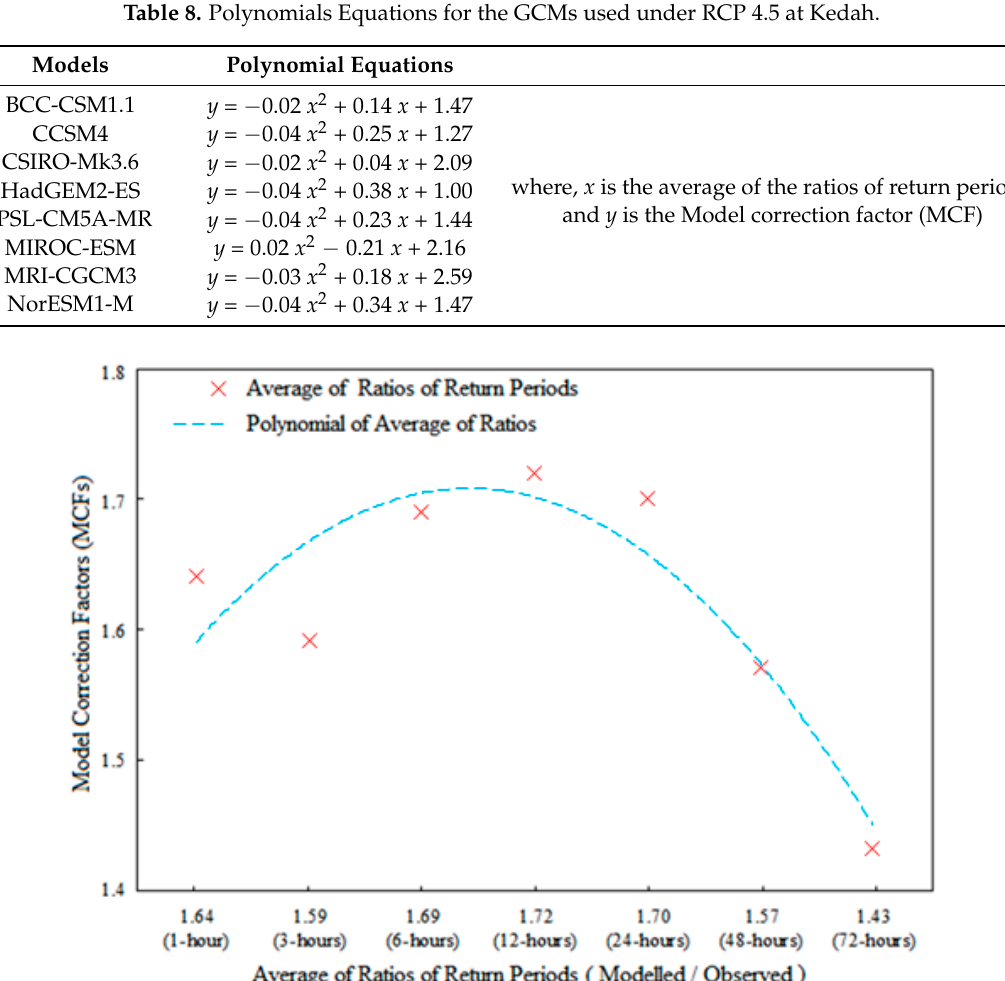
Figure 8. Model Correction Factors (MCFs) for modelled rainfall intensities fitted into a polynomial equation for BCC-CSM1.1 for RCP 4.5 at Kedah.